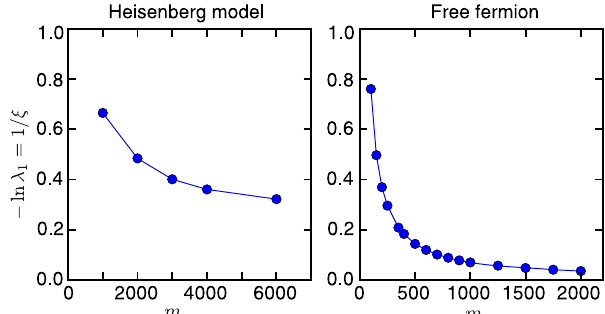
FIG. 15. The dependence of the inverse of correlation ( 1 = ξ ) at the Dirac point versus the bond dimension m . We show both the kagome Heisenberg model (YC8-2, J 2 ¼ 0 . 05 ) and the free- fermion model.